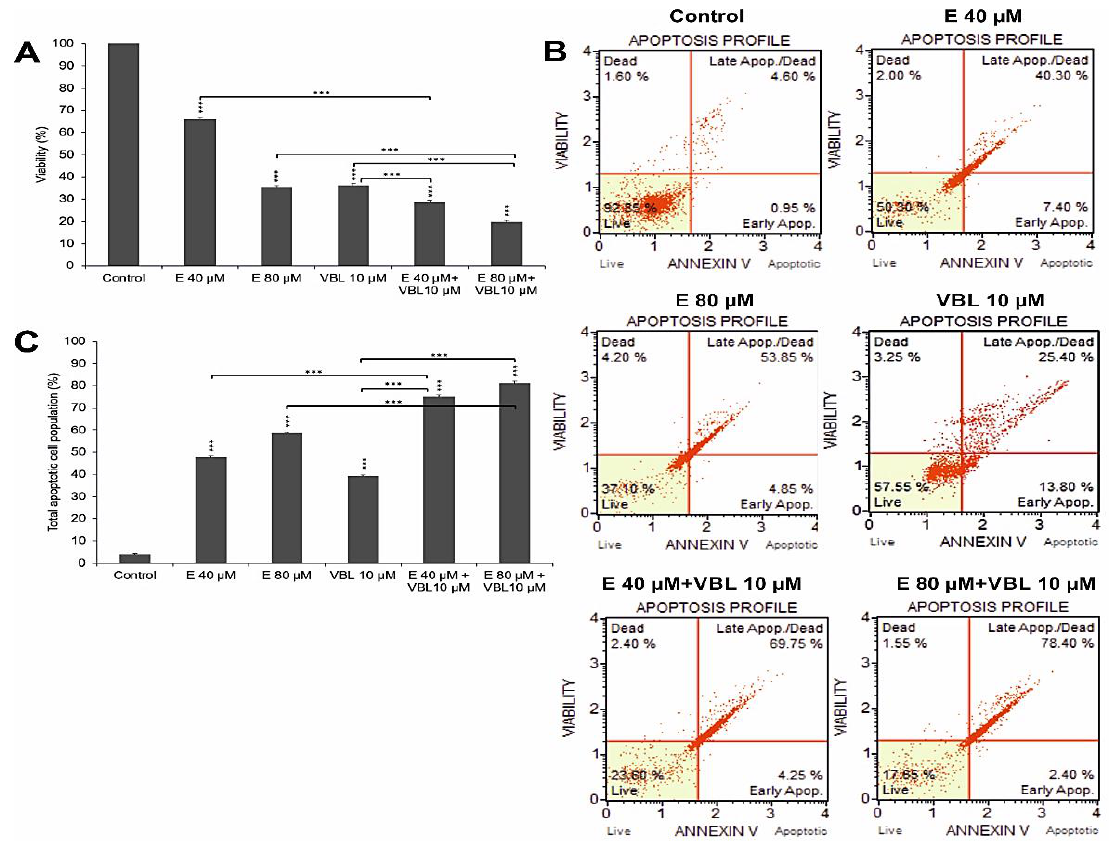
Figure 1. Emodin and vinblastine decrease viability and induce apoptosis in HeLa cells. Cells treated for 24 h with 40 and 80 µM concentrations of emodin, vinblastine (10 µM), and the combined action of 10 µM vinblastine with emodin at concentrations of 40 and 80 µM. ( A ) Effect of emodin and vinblastine on cell viability as assessed by MTT test. ( B ) Level of apoptosis assessed by annexin V-PE/7-AAD staining. Live cells (annexin V-PE-/7-AAD-), cells in early- (annexin V-PE+/7-AAD-) and late-stage apoptosis (annexin V-PE+/7-AAD+), and dead cells (annexin V-PE-/7-AAD+). ( C ) Percentage of apoptotic cells induced by tested agents. Differences statistically confirmed at: *** p < 0.001. 2.2. Emodin and Vinblastine Induce Cell Apoptosis by Activating Caspase